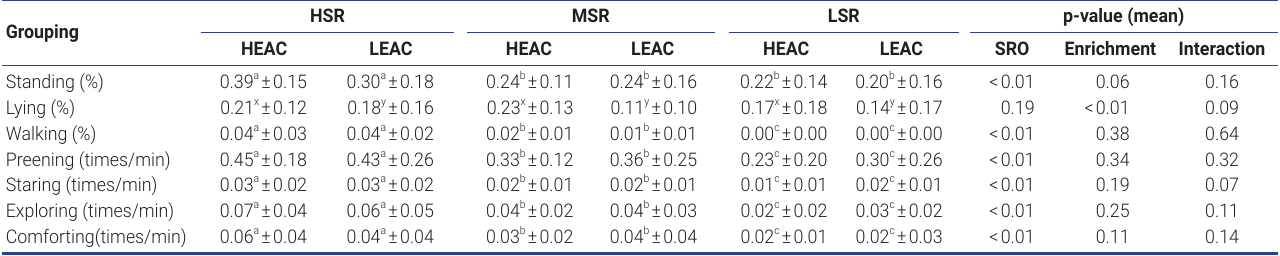
Table 5. Effects of social ranking order on perching behavior in high or low perch and dust-bath allocation (mean±standard deviation)